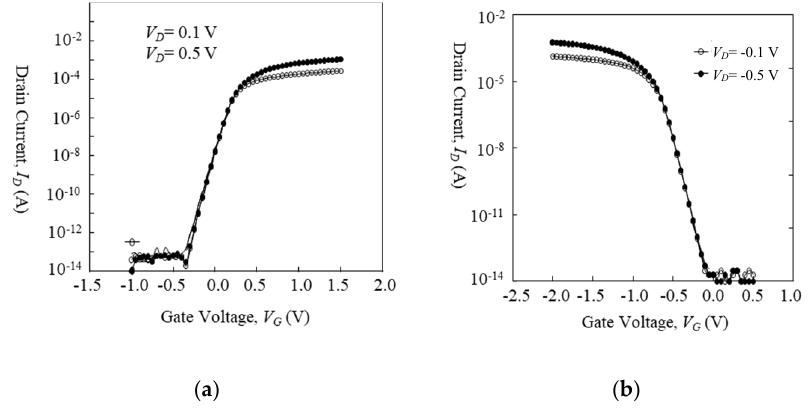
Figure 2. I D vs. V G characteristics of 1- µ m-long gate MOSFETs. ( a ) n-type IC-MOSFET, ( b ) p-type BC-MOSFET. V sub = 0 V.